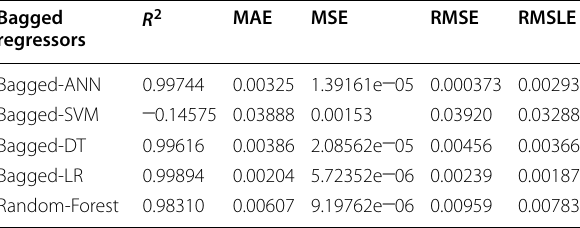
Table 3 Prediction performance of bagging approach type of ensemble technique Bagged regressors